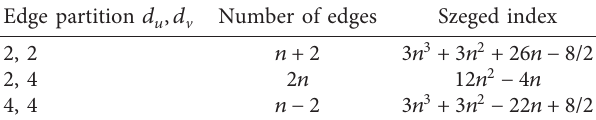
Figure 4: Para chain of n order. Table 13: Edge partition of ortho chain of n order.